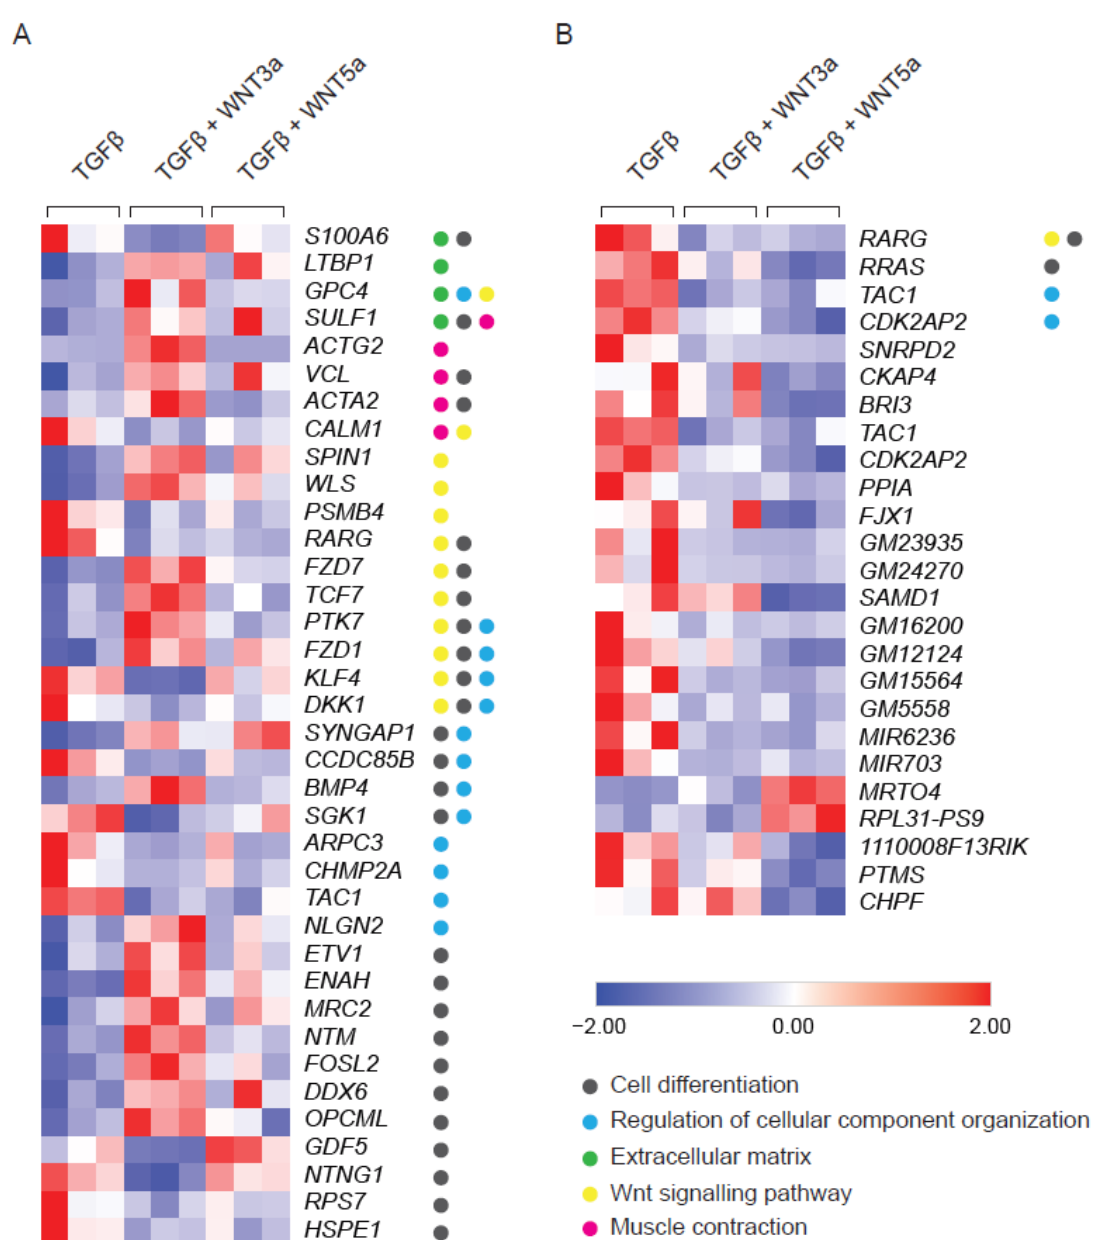
Figure 2. RNAseq analysis of TGF- β -activated fibroblasts following WNT3a or WNT5a treatment. Cardiac fibroblasts were stimulated with WNT3a or WNT5a in the presence of TGF- β for 72 h. Panel ( A ) shows a heat map of fibrosis-related genes differentially expressed (fold change > 2 and p < 0.05) in fibroblasts treated with WNT3a/TGF- β versus TGF- β alone ( n = 3). All dysregulated genes of WNT3a/TGF- β versus TGF- β are presented in the Supplementary Figure S1. Panel ( B ) represents a heat map of all differentially expressed genes (fold change > 2 and p < 0.05) in cardiac fibroblasts treated with WNT5a/TGF- β versus TGF- β alone ( n = 3). GO categories: Cell differentiation (GO:0030154), Regulation of cellular component organization (GO:0051128), Extracellular matrix (GO:0031012), WNT signaling pathway (GO:0016055) and Muscle Contraction